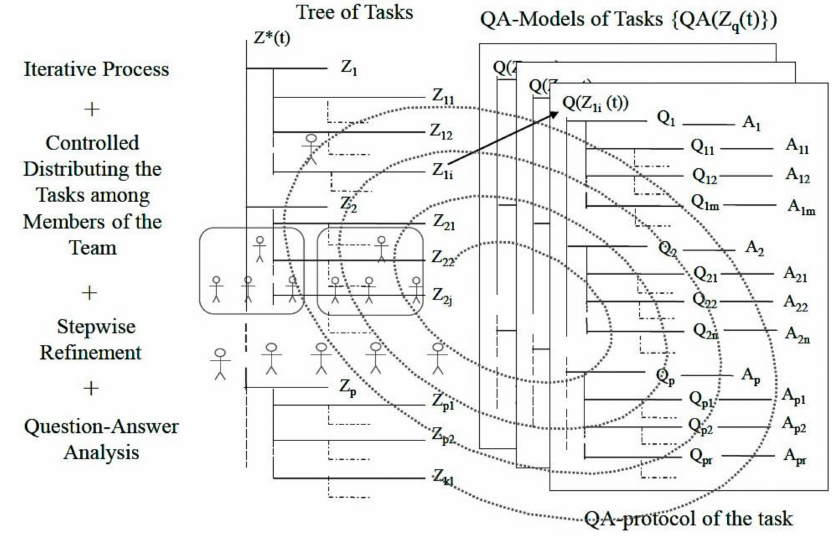
Figure 4. Creating the tree of tasks for the